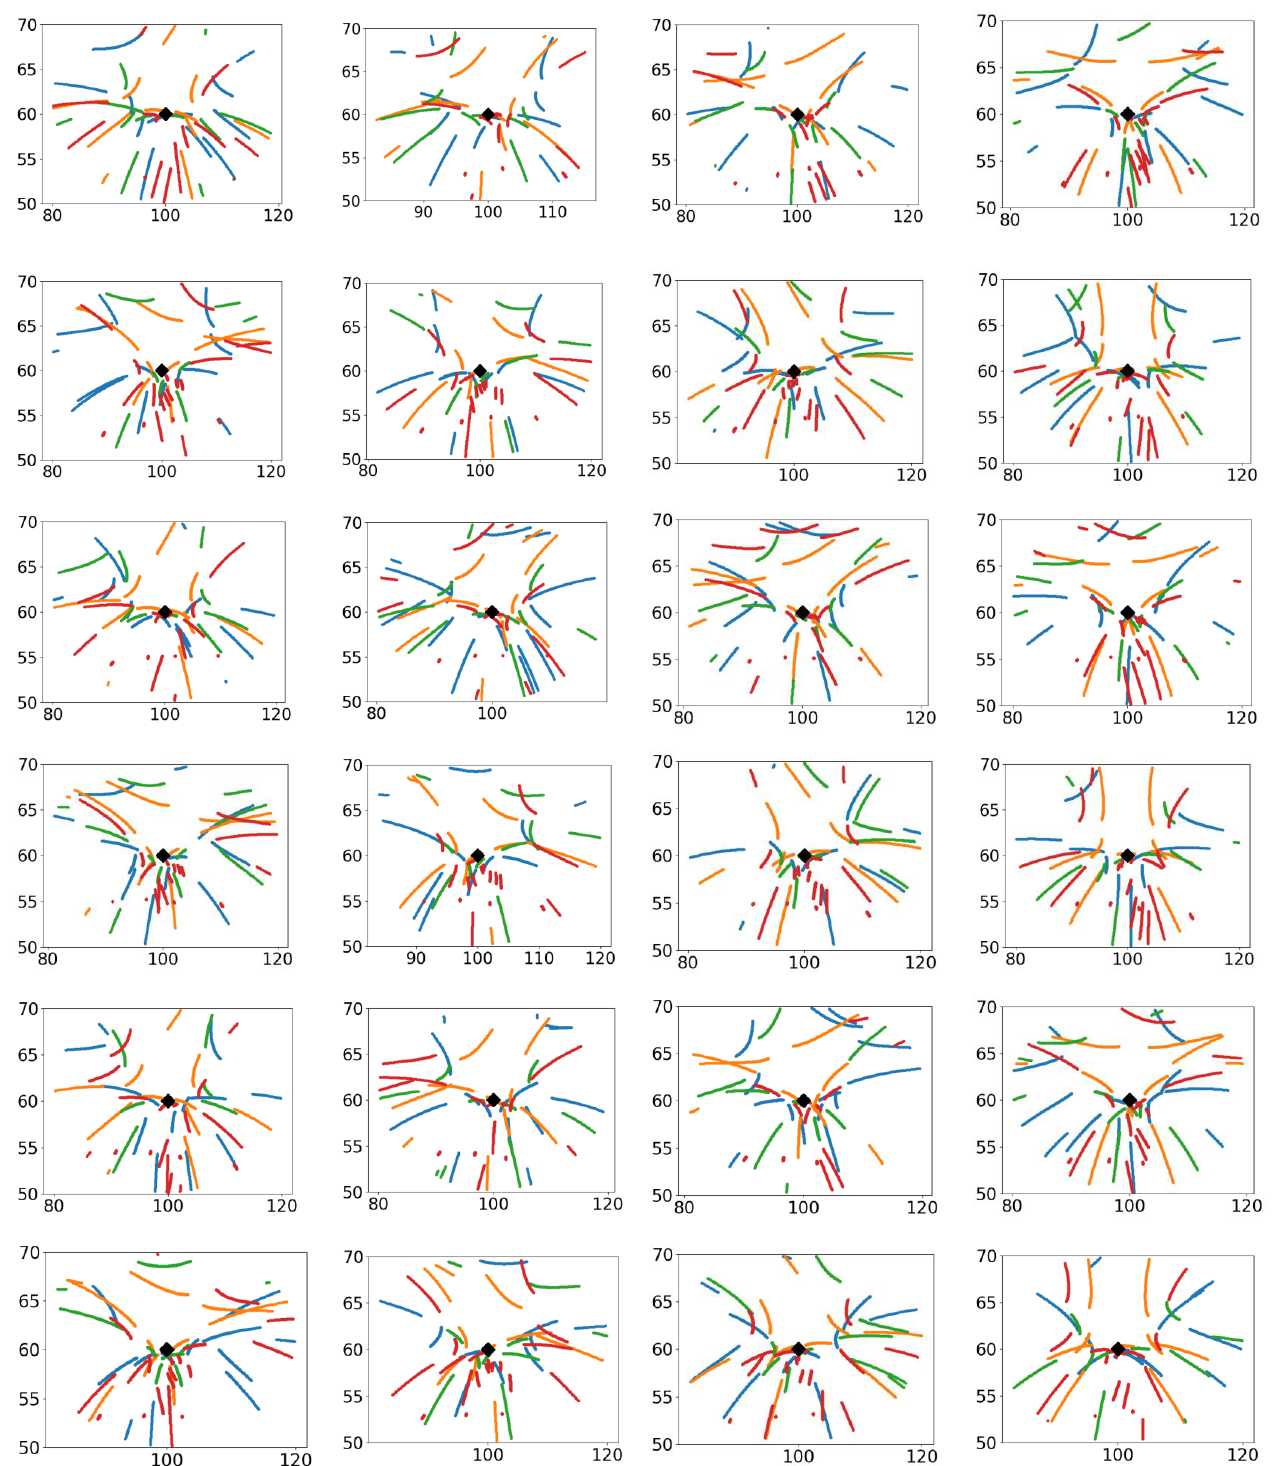
Figure 11. Hourly ionospheric points per day. Dark blue dots signify GPS, orange — GLONASS, green — Galileo, red – BeiDou. The rhomb marks the station position.